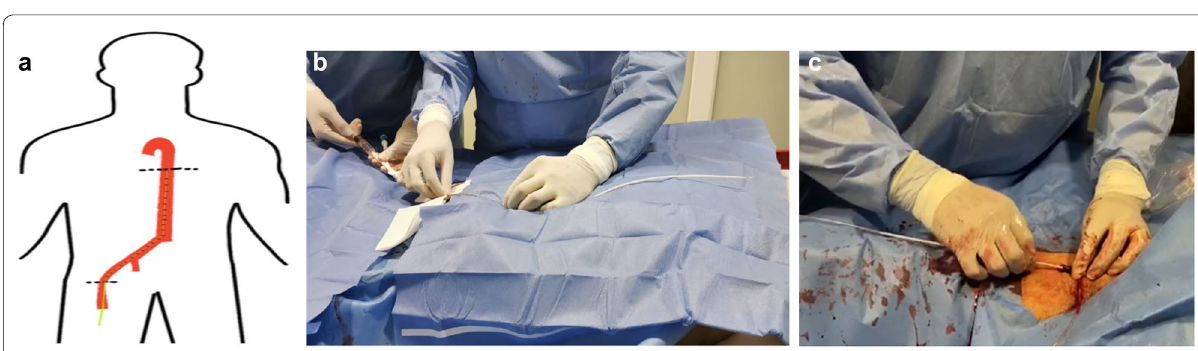
Fig. 4 a Distance from the second intercostal space to the right common femoral artery. b Measurement of the distance for inserting the IAoBC. c Passage of the IAoBC